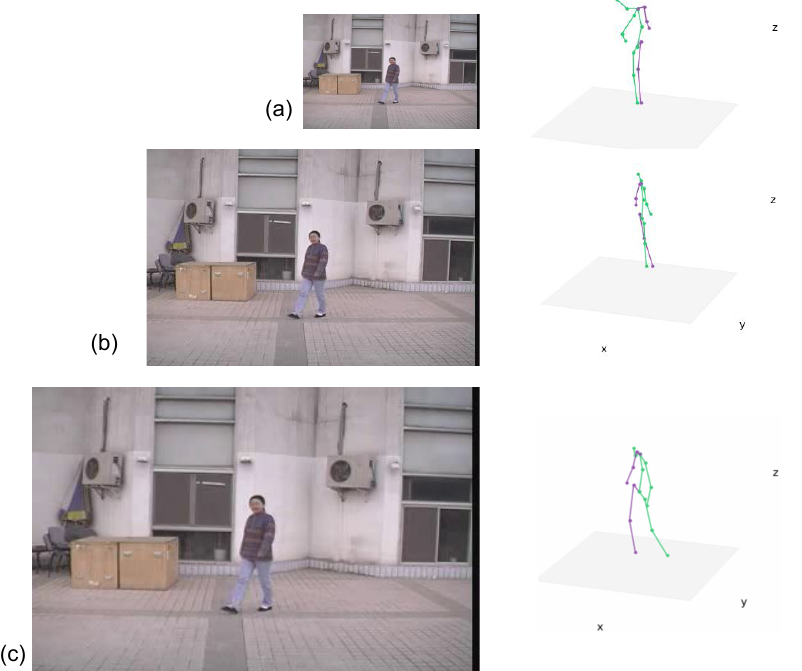
Figure 21. The test with scale-up images that shows a better 3D pose estimation. ( a ) The original image size 352 × 240. The 3D estimation result shows some deformation ( b ) The scaled image to 704 × 480. No more severe deformation is found. Yet, it is not enough to extract gait features ( c ) The scaled image to 1126 × 768. The human subject size is roughly 100 × 250 which is big enough as an input to 2D and 3D pose